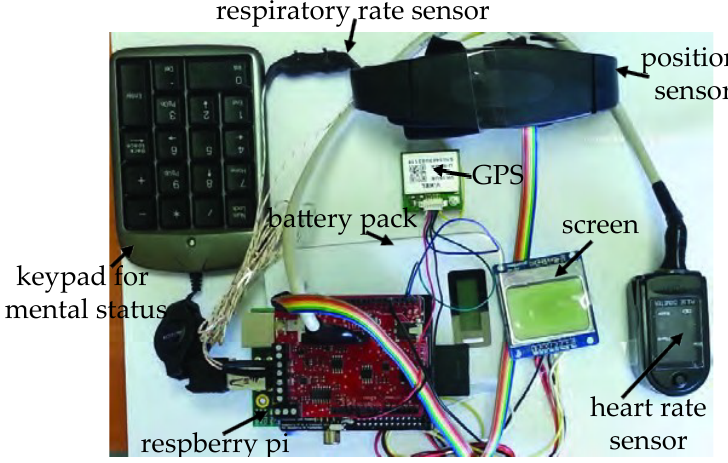
Figure 2. DigiAID hardware